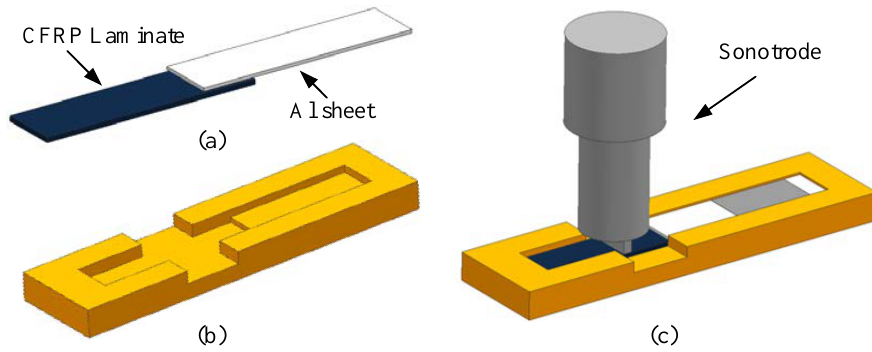
Figure 3. Size of the joint sample. CFRP, carbon fiber-reinforced plastic.